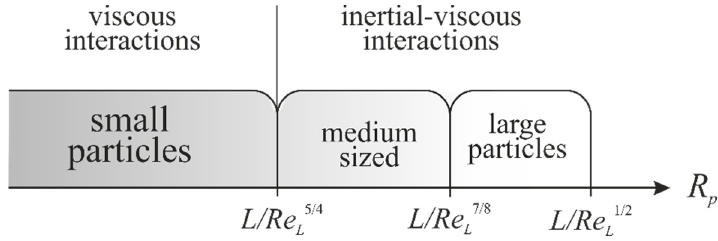
Figure 2. Classification of particles by size and type of dynamic interaction with BL flow.